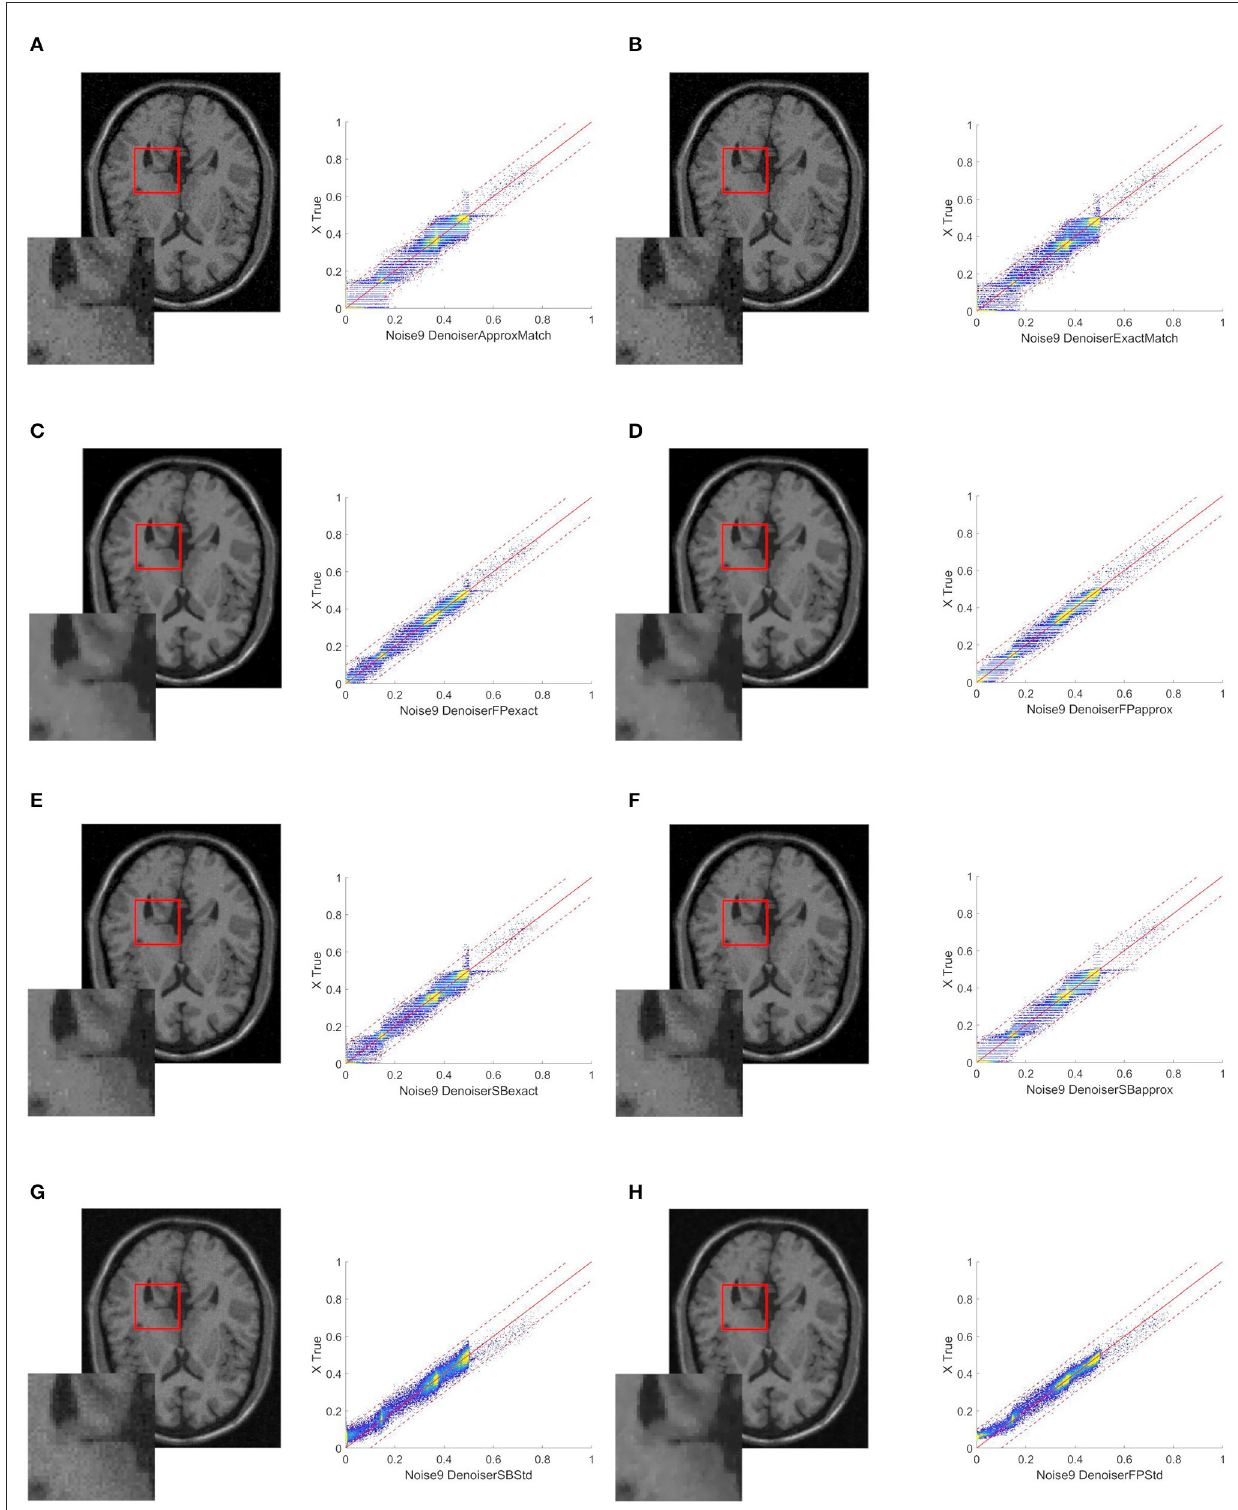
FIGURE3 Resulting images when the target image is collected at a distance of –5 mm from the references, also with 3% noise. (A) ExactMatch and (B) ApproxMatch applied to the image with 9 % noise. (C) FP exact and (D) FP approx denoiser applied to the image with 9 % noise. (E) SB exact and (F) SB approx applied to the image with 9 % noise. (G) SB standard and (H) FP standard applied to the image with 9 %